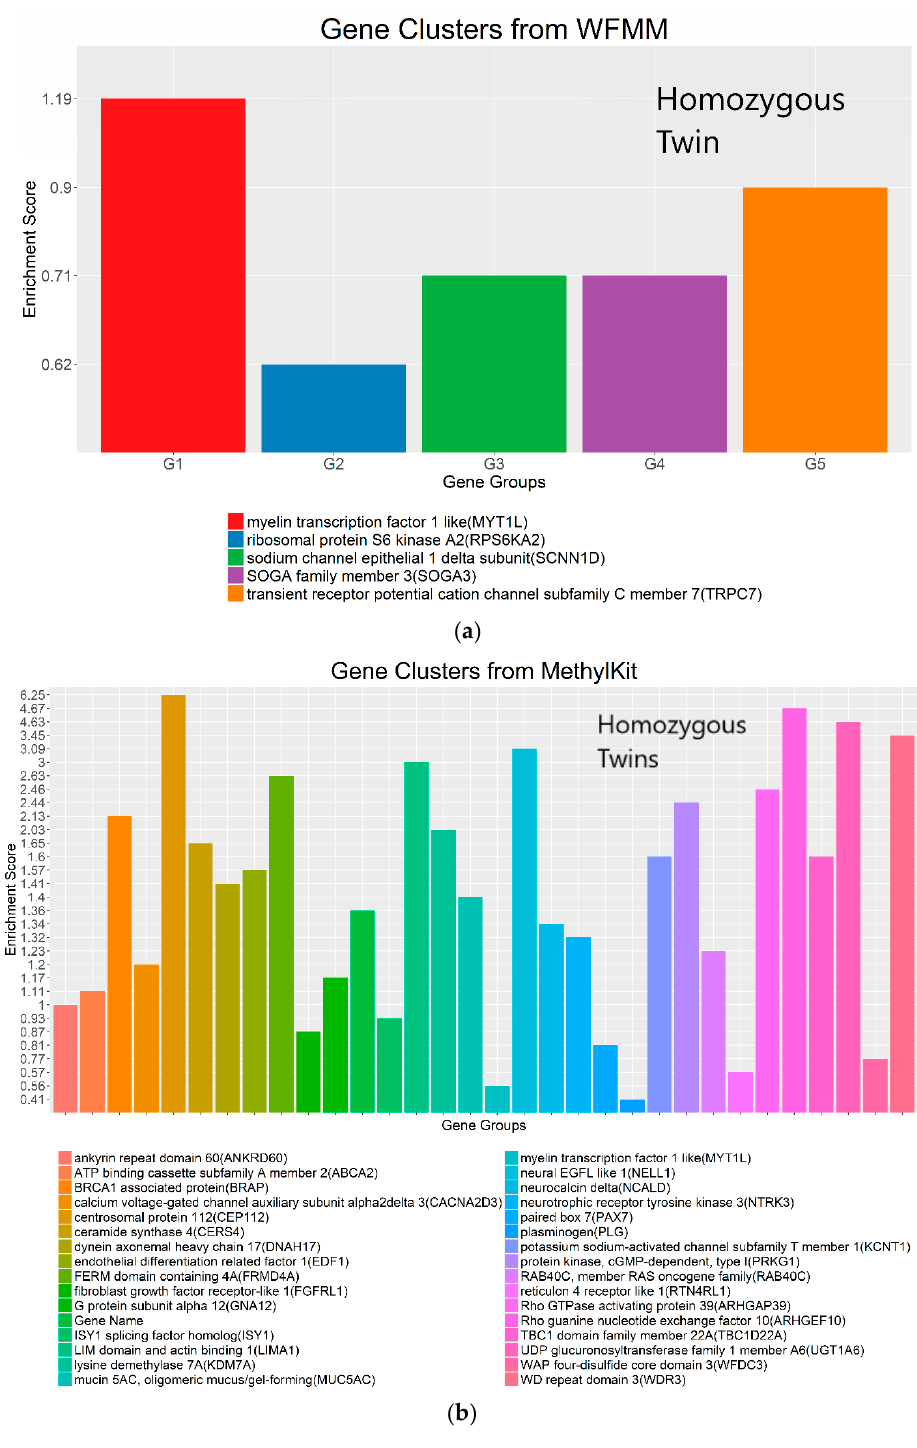
Figure 8. Gene clusters based on the gene ontology of molecular function for significant genes detected by WFMM with δ = 3.44 × 10 − 5 ( a ) and methylKit (difference = 4.34 × 10 − 5 ; q value = 1.00) ( b ).